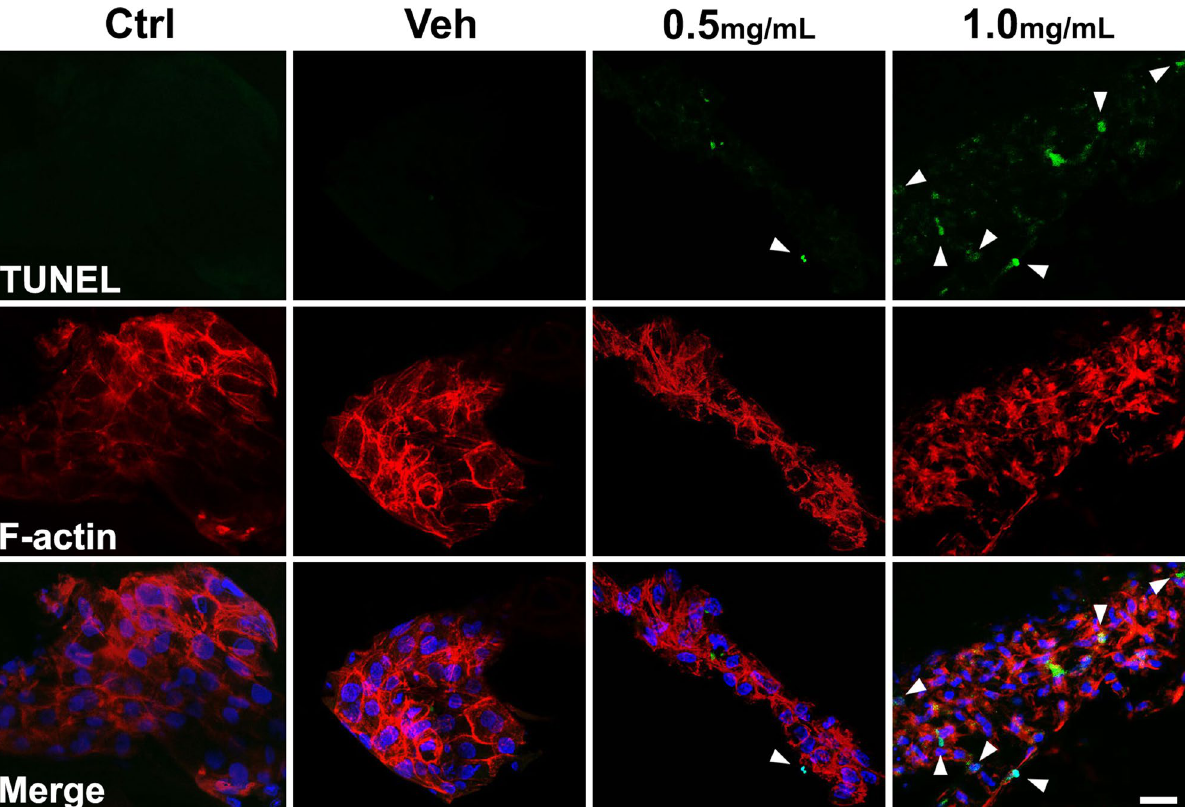
Figure 6. Increased apoptosis of porcine corneal endothelium after moxifloxacin exposure. Porcine corneas were stained with TUNEL after 24 h exposure to various concentrations of moxifloxacin (MXF). Compared to negative control and vehicle control, increased apoptosis of corneal endothelium was observed in corneas exposed to MXF (0.5 and 1.0 mg/mL). Green: TUNEL; Red: F-actin; Blue: DAPI. Scale bar: 20